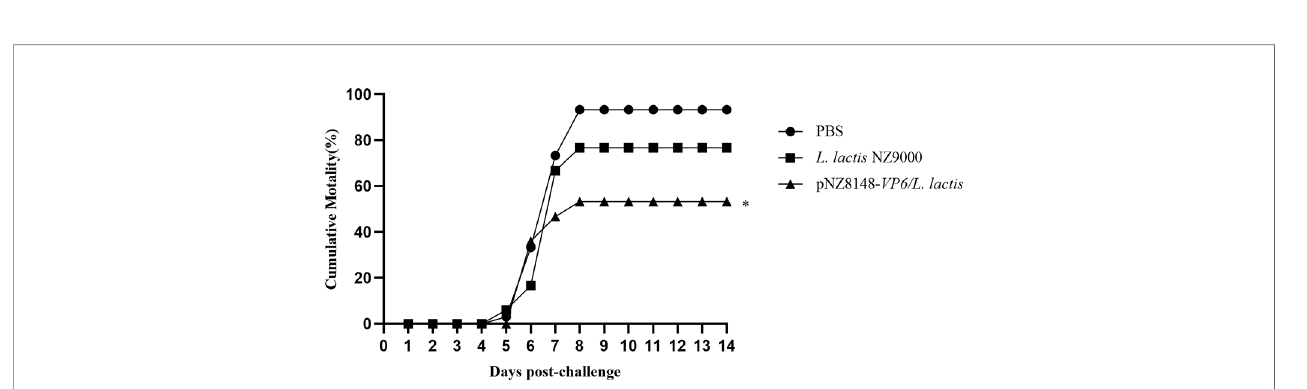
FIGURE 4 | Cumulative mortality curves of vaccinated fi sh exposed to GCRV-HuNan1307. Mortality was monitored daily for 14d post-challenge. *P < 0.05 between immunized and control groups at day